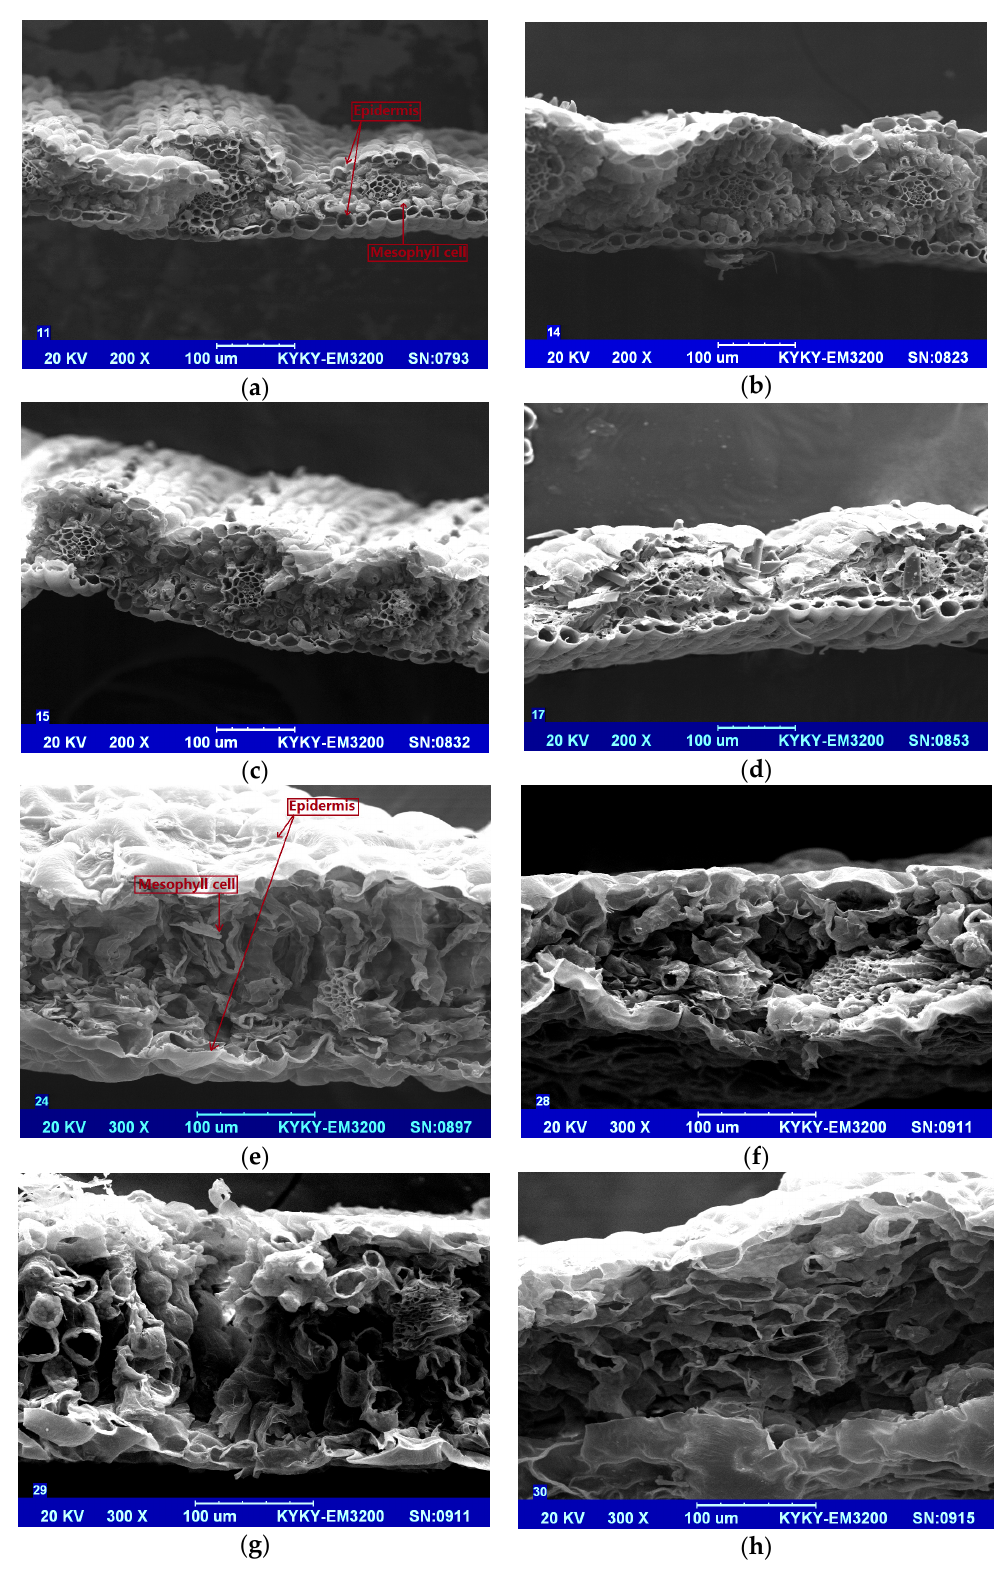
Figure 3. Scanning electron microscopy (SEM). images of leaves with different copper contents in soil: ( a ) Normal wheat; ( b ) Wheat with 200 mg/kg copper content in soil; ( c ) Wheat with 400 mg/kg copper content in soil; ( d ) Wheat with 1600 mg/kg copper content in soil; ( e ) Normal pak choi; ( f ) Pak choi with 200 mg/kg copper content in soil; ( g ) Pak choi with 400 mg/kg copper content in soil; ( h ) Pak choi with 800 mg/kg copper content in soil.